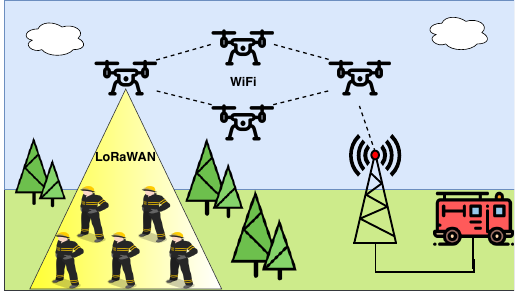
Figure 1. High level view of LoRaUAVsystem